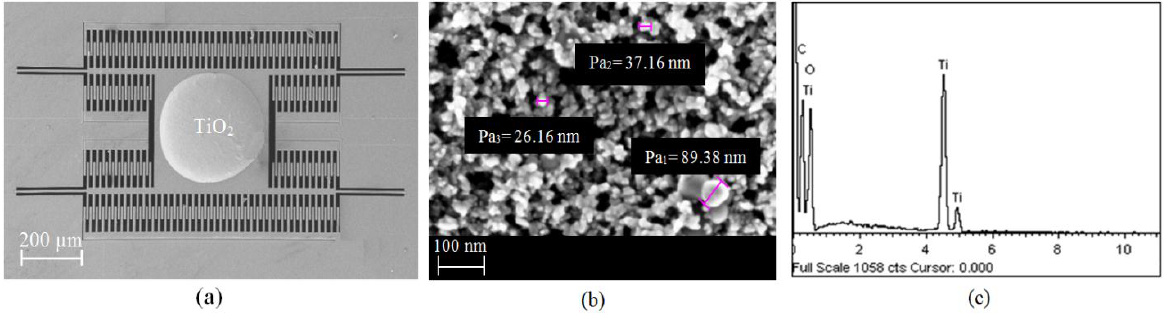
Figure 6. ( a ) FESEM image of CMOS-MEMS device with TiO 2 paste deposited on its plate; ( b ) Zoomed-in FESEM micrograph of TiO 2 nanoparticles. ( c ) EDX-spectrum of the TiO 2 on the plate.